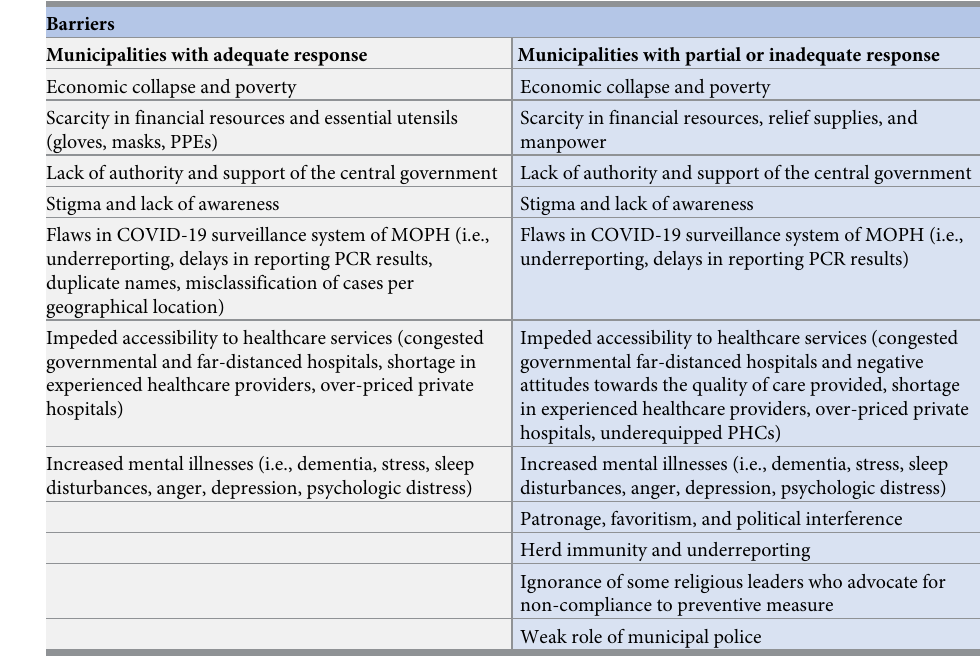
Table 4. Barriers facing municipalities during the